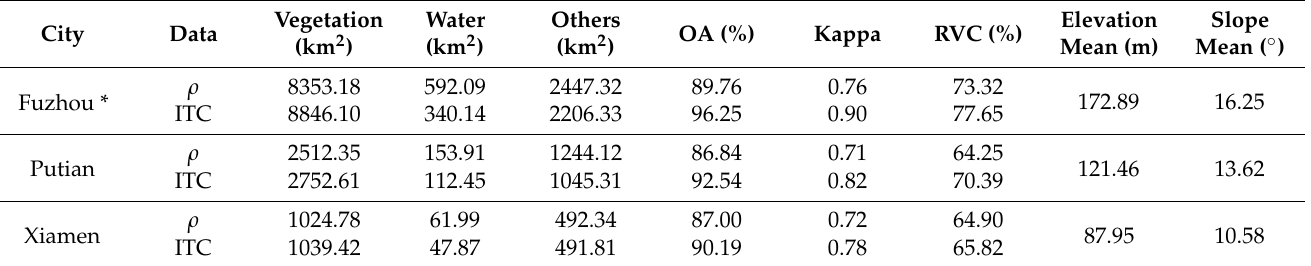
Table 3. Area of classified vegetation, water, and other land covers of three cities using surface reflectance and the ITC-corrected reflectance, and corresponding regional vegetation coverage (RVC), elevation mean, and slope mean. The OA is overall